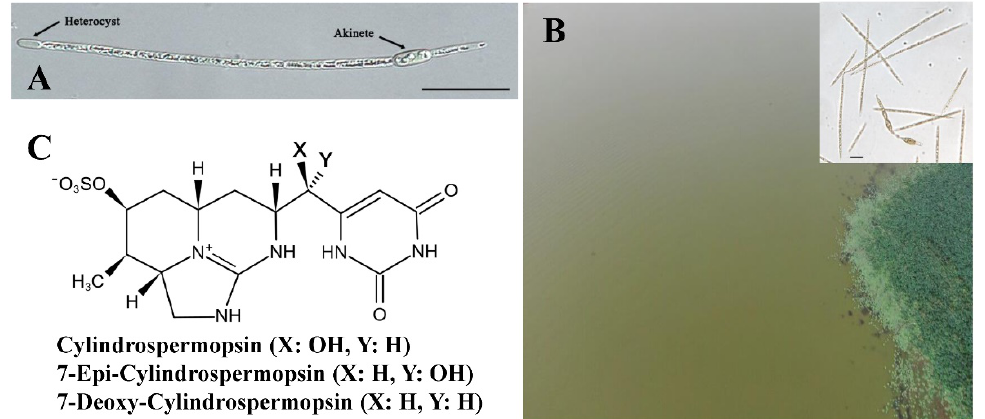
Figure 1. Cell differentiation of R. raciborskii filament ( A ), aerial view of the R. raciborskii bloom ( B ), and chemical structure of cylindrospermopsins ( C ). Inset in ( B ) is a microscopic graph of R. raciborskii bloom. Scale bars in ( A ) and ( B ), 10 µm.